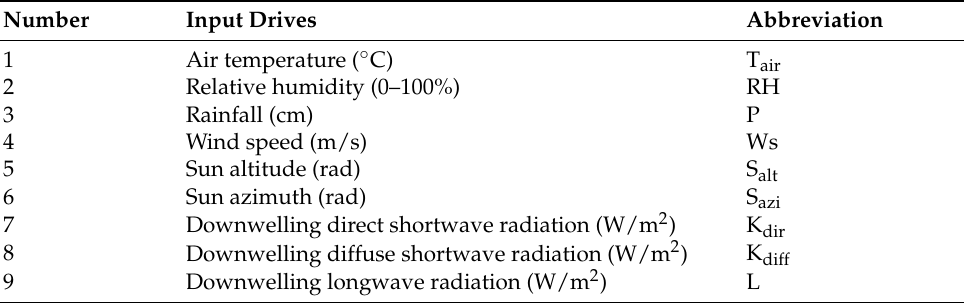
Table 1. Overview of input drives for DFMC. These variables are recorded each hour.